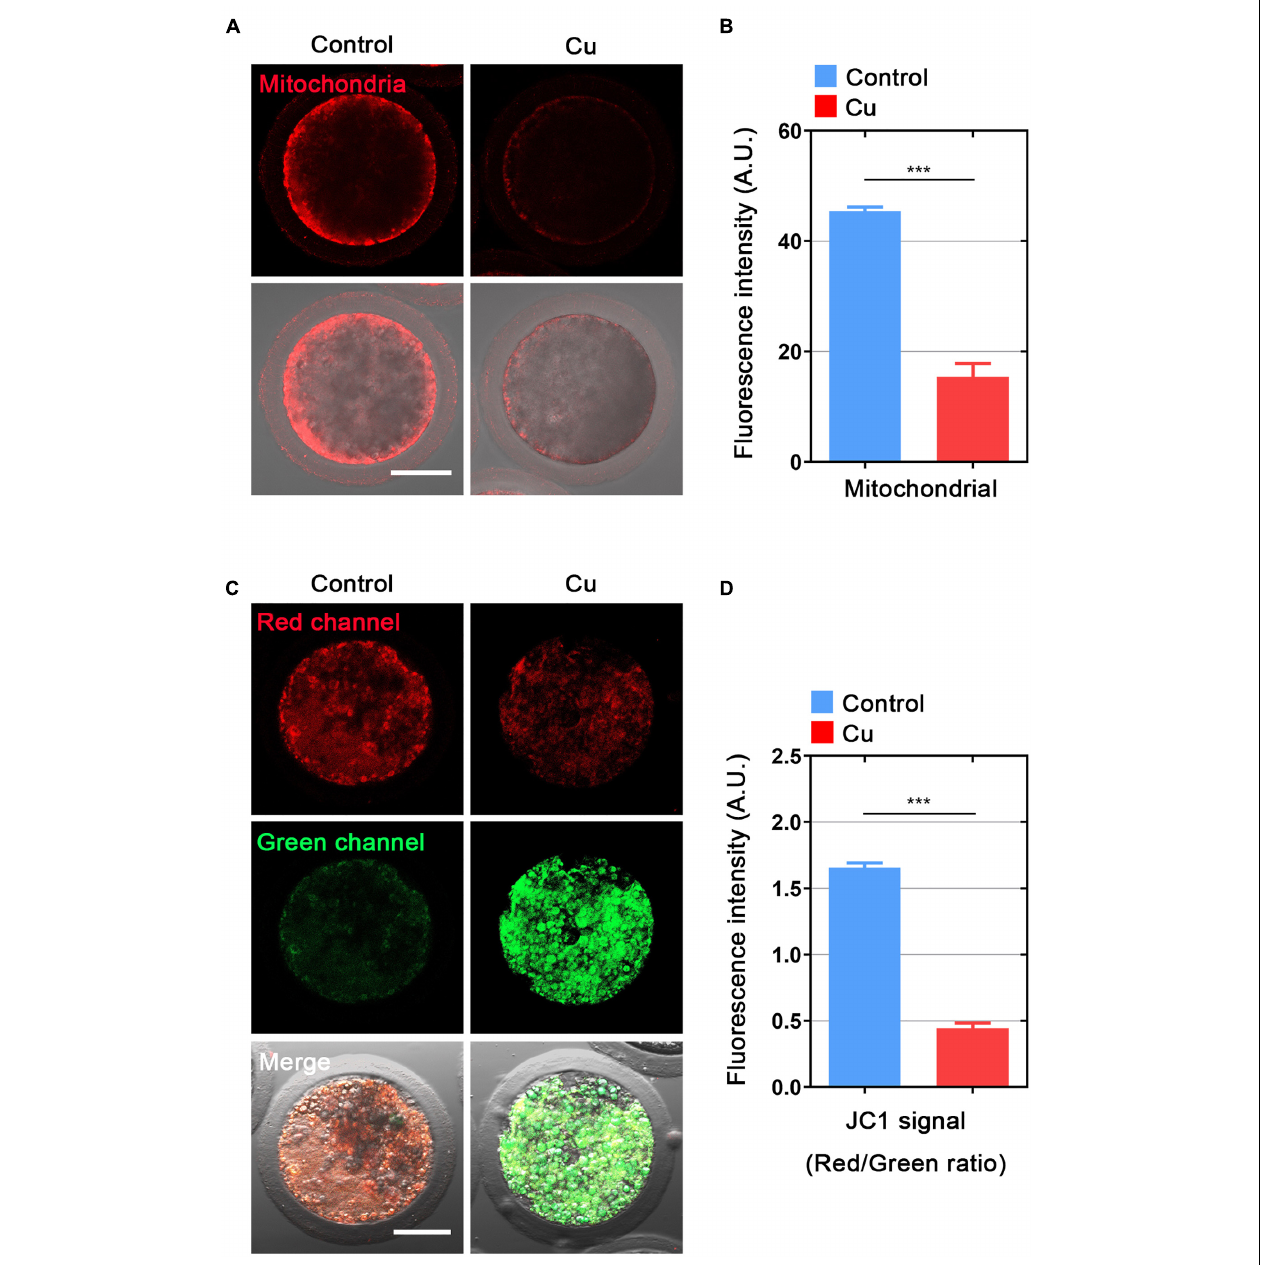
FIGURE 5 | Effects of Cu exposure on the distribution and function of mitochondria in porcine oocytes. (A) Representative images of mitochondria in the control and Cu-exposed oocytes. Scale bar, 50 µ m. (B) The immunofluorescence intensity of mitochondrion signals was recorded in the control and Cu-exposed oocytes. (C) Mitochondrial membrane potential ( (cid:49)(cid:57) m) was detected by JC-1 in the control and Cu-exposed oocytes (Green, low (cid:49)(cid:57) m; Red, high (cid:49)(cid:57) m). (D) The ratio of red and green fluorescence intensity was recorded in the control and Cu-exposed oocytes. Data of (B) and (D) were expressed as the mean percentage of at least three independent experiments (mean ± SEM). *** P <